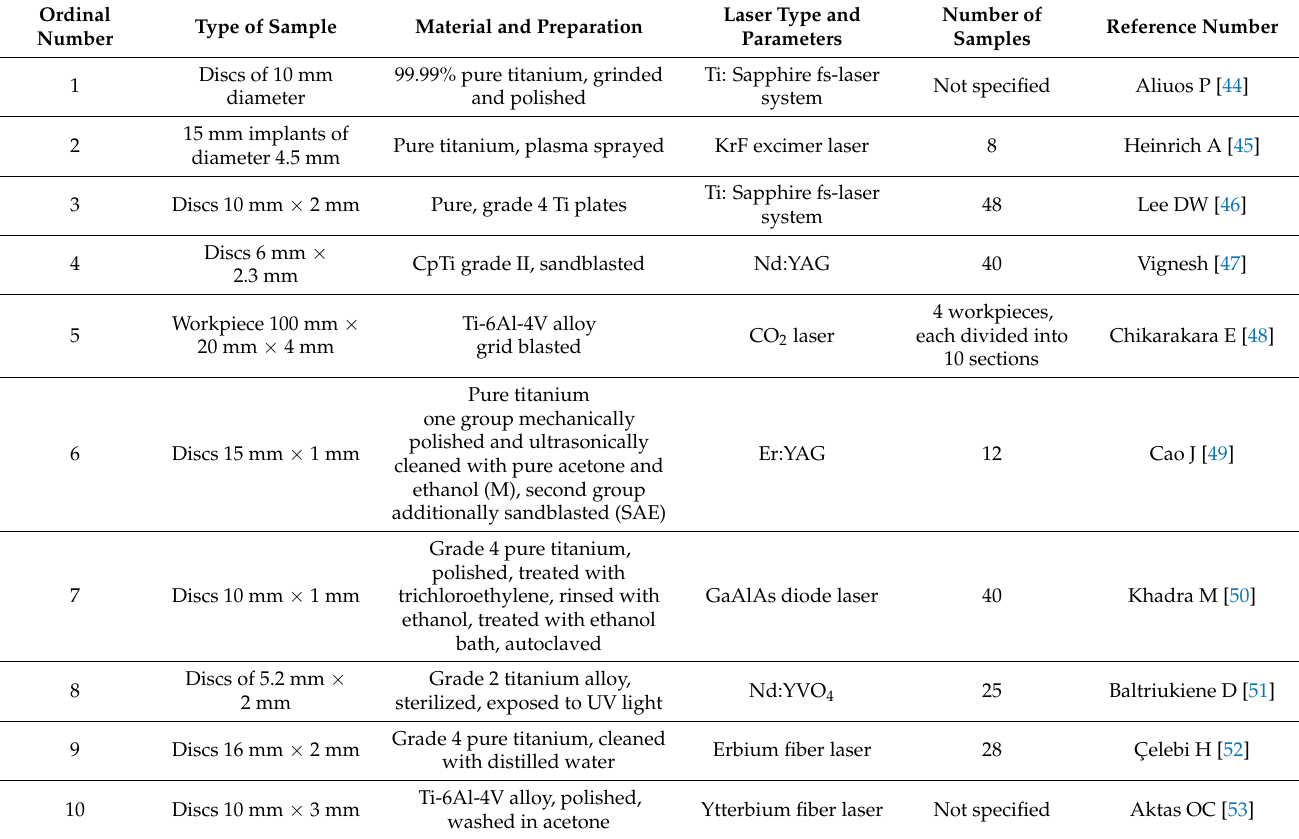
Table 2. General characteristic of the included